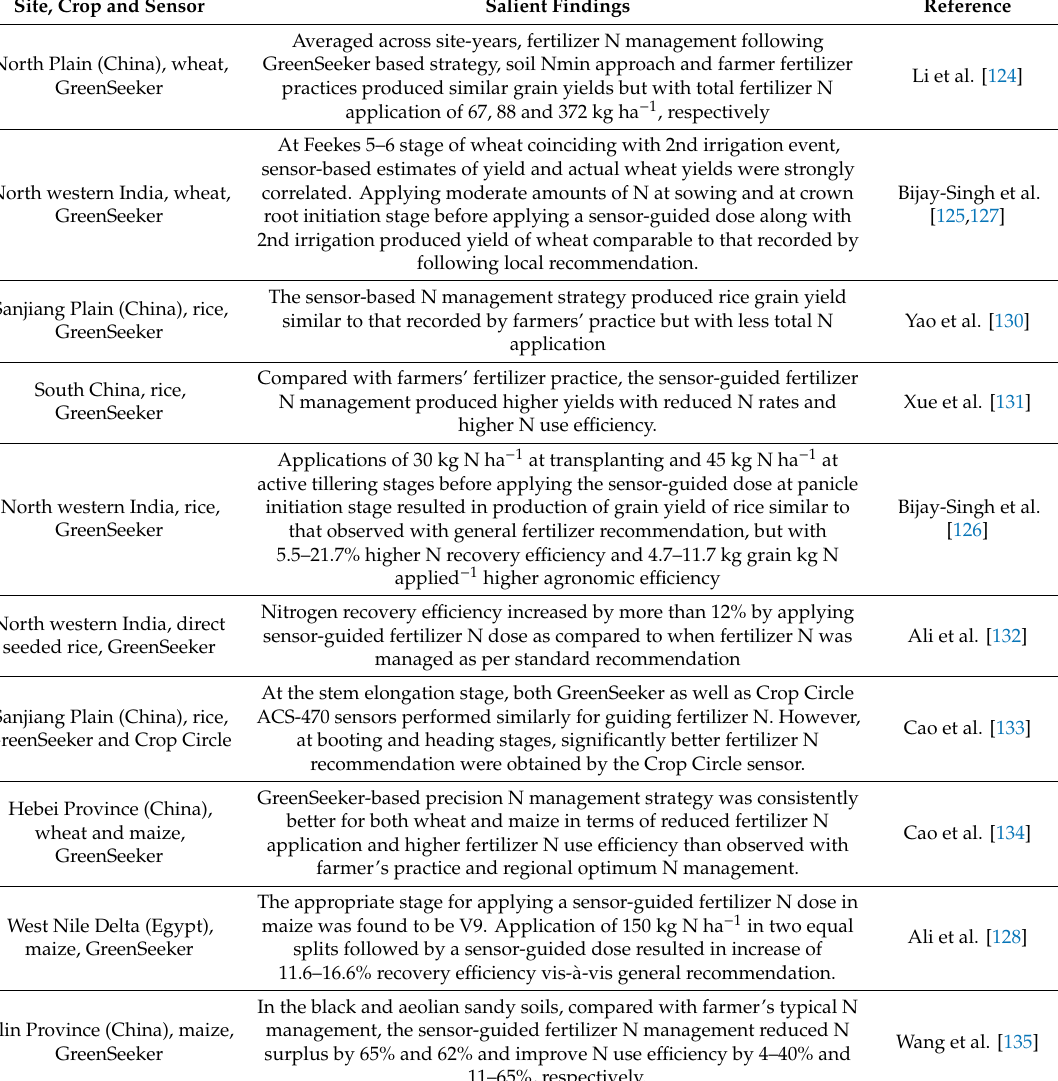
An account of canopy reflectance sensor-based fertilizer N management studies in developing